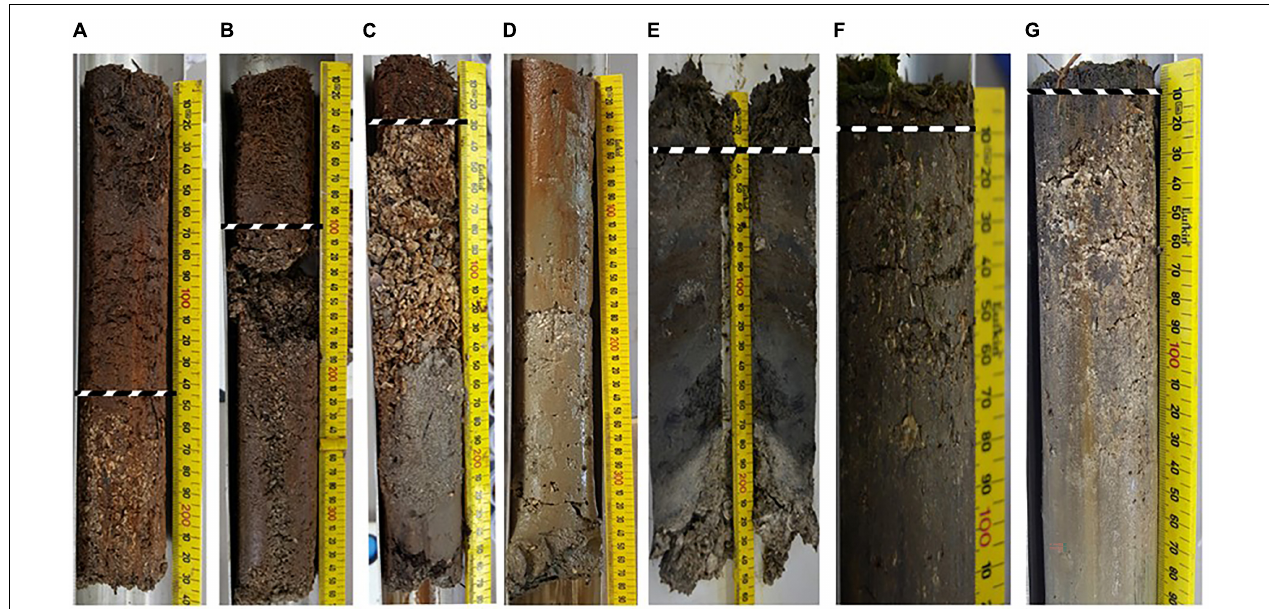
FIGURE 3 | Sediment cores collected from the recovered, rehabilitated, and salt pond sites. The images show the horizons (dashed white line) between an upper organic layer and the deeper levels of shell and gravel. (A) Sarcocornia core 2L (recovered site); (B) Sarcocornia/Tecticornia core 2M (recovered site); (C) Tecticornia/Suaeda core 2H (recovered site); (D) Salt pond core; (E) Sarcocornia core 1L (rehabilitated site); (F) Sarcocornia/Tecticornia core 2M (rehabilitated site); and (G) Tecticornia/Suaeda core 2H (rehabilitated